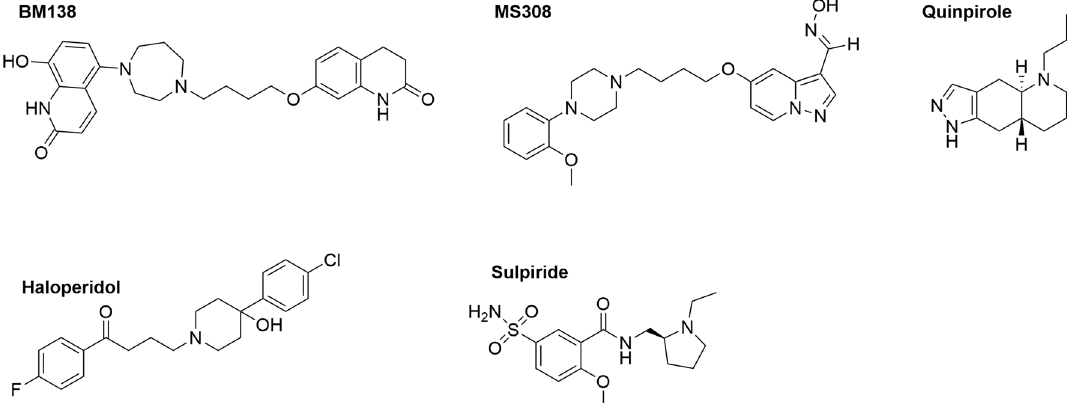
Figure 1. Chemical structures of the tested ligands with different functional properties. BM138 and MS308 are recently developed biased agonists, quinpirole is a balanced agonist, haloperidol and sulpiride are antagonists of D 2